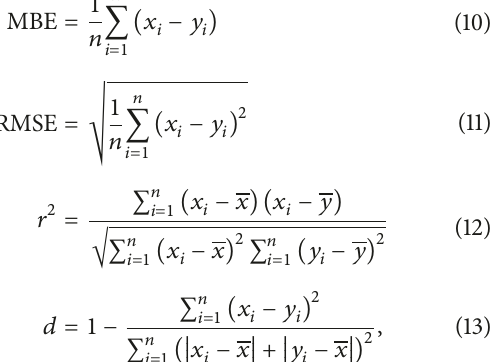
and Willmott index of agreement “ 𝑑 ” (see (13)) were